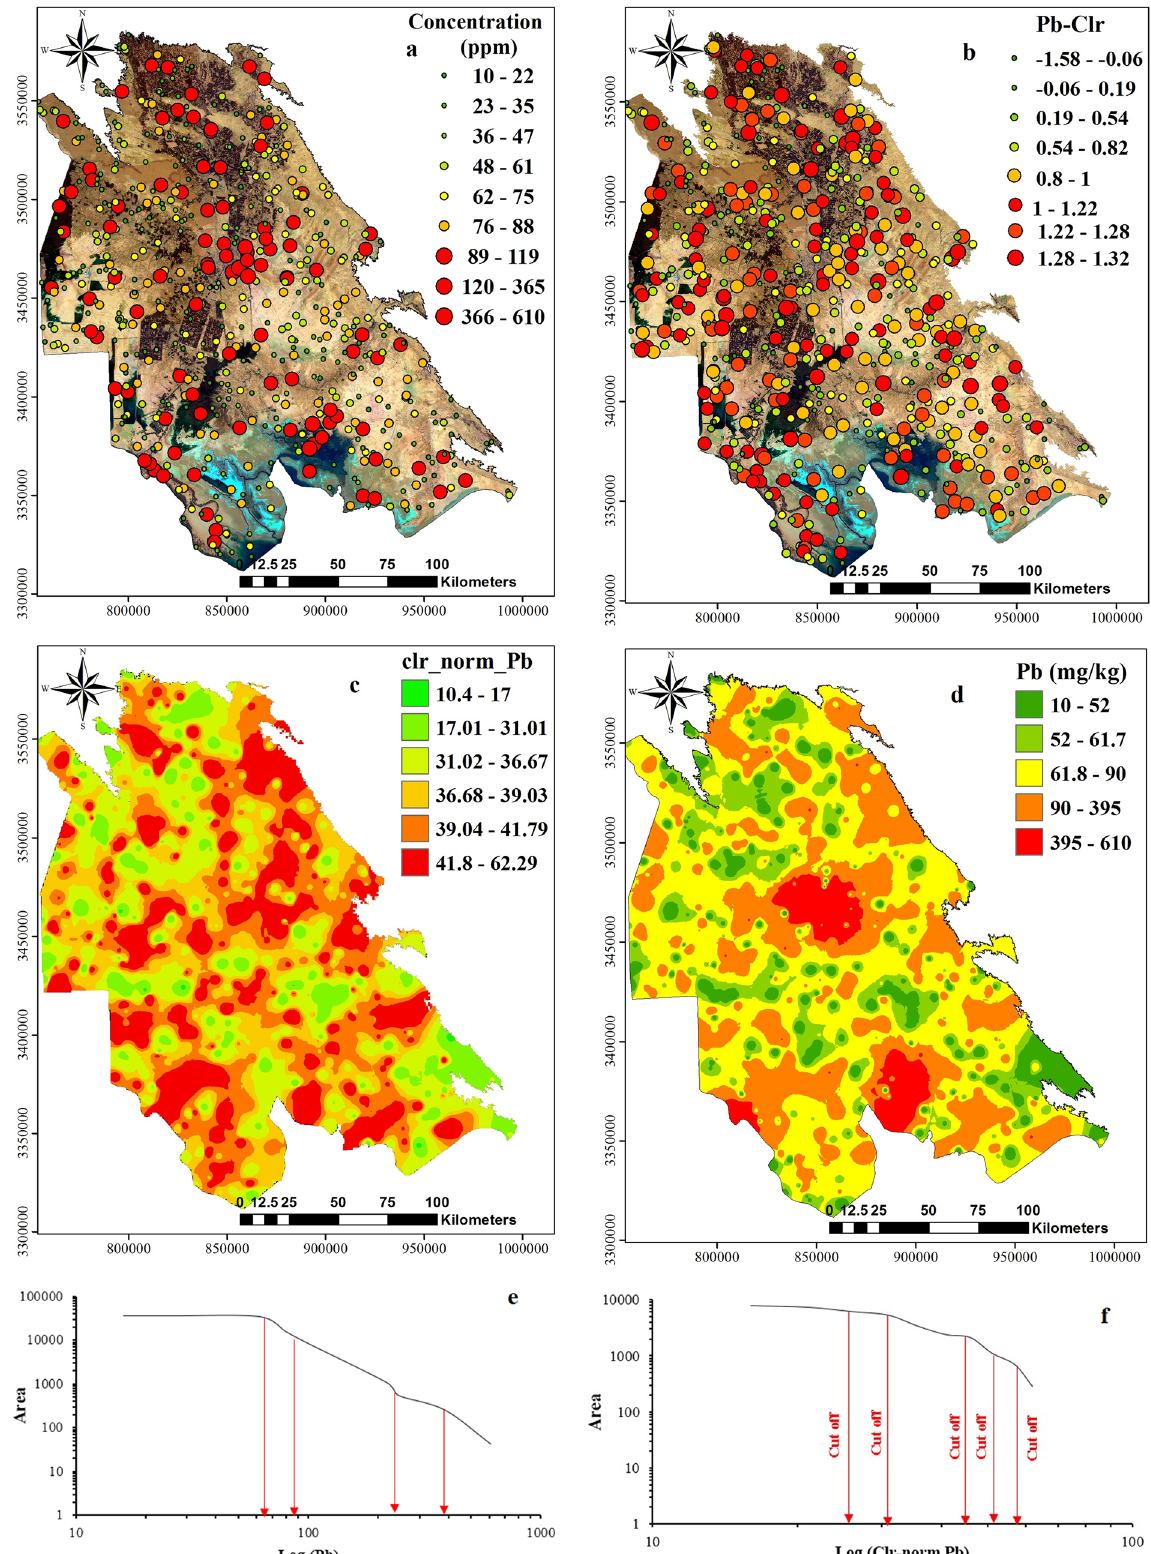
Figure 9. Interpolated (MIDW) maps for (a) Pb raw data; (b) Pb clr-transformed data, and corresponding plots of C-A model for map classification. the image was made by ArcGIS10.2, background from Google Earth (Image: Google,